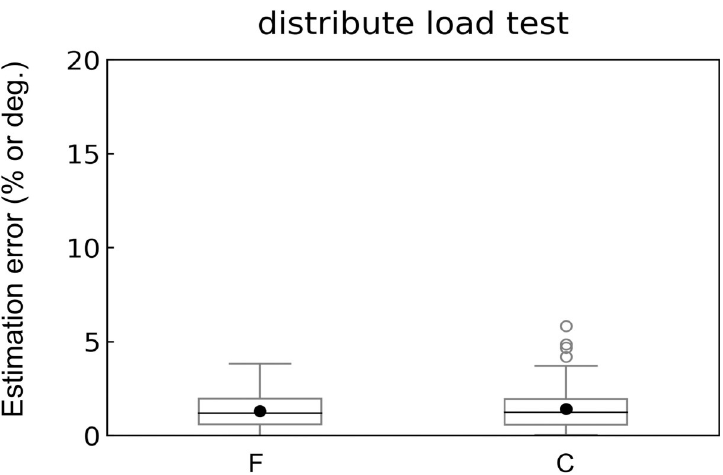
Fig 6. Box plots of estimation errors for the distributed loading experiment. F, the amount of force; C, the centroid of force. Each black solid circle in the panel shows the average value. For the calculation of the estimation errors, see the caption of Fig